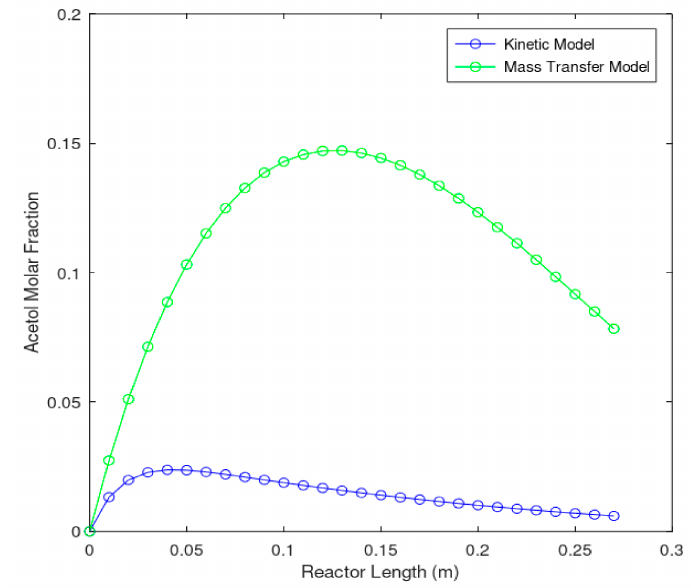
Figure 6. Comparison of the flows of acetol in models with the kinetics model and the mass transfer model.